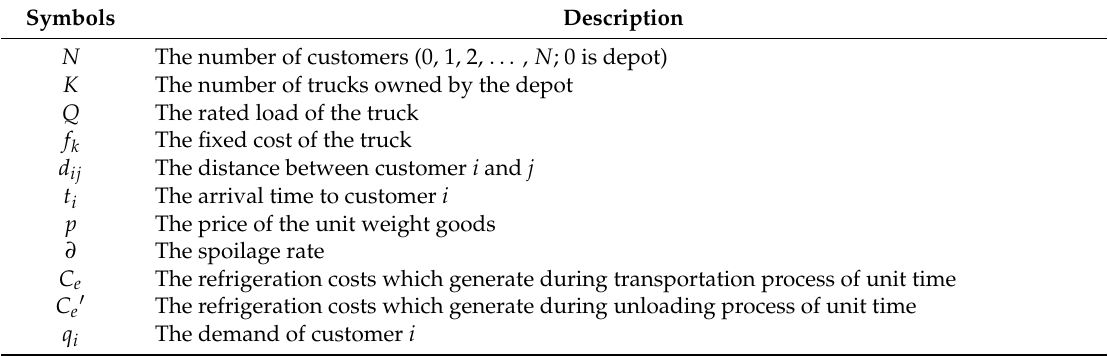
Table 1. Description of the